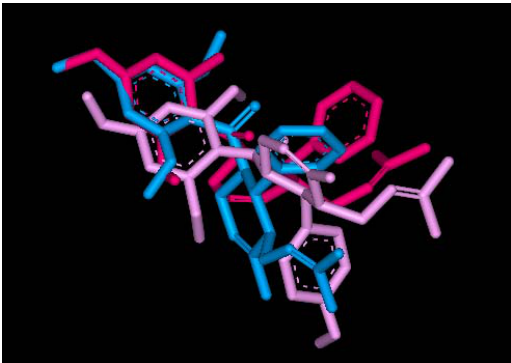
Figure 6. Spatial arrangement of the binding site for ( a ) 246DA ( b ) 20H46DA and ( c ) 2446DA.